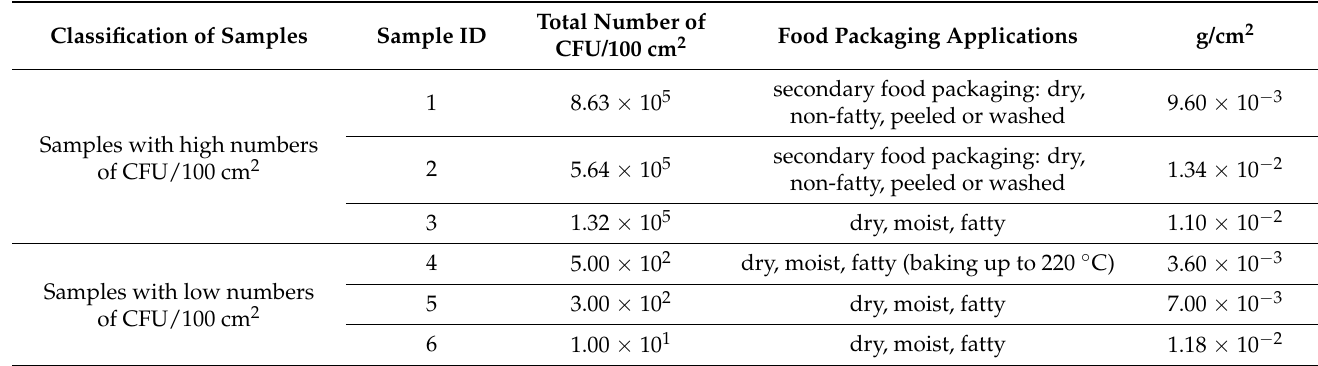
Table 1. Packaging material samples and corresponding food applications. All tested samples were coded with a sequential number. The total numbers of colony-forming units per 100 square centimeters (CFU/100 cm 2 ) were measured according to ISO 4833-1:2013 [18]. The packaging applications are in accordance with the manufacturer’s